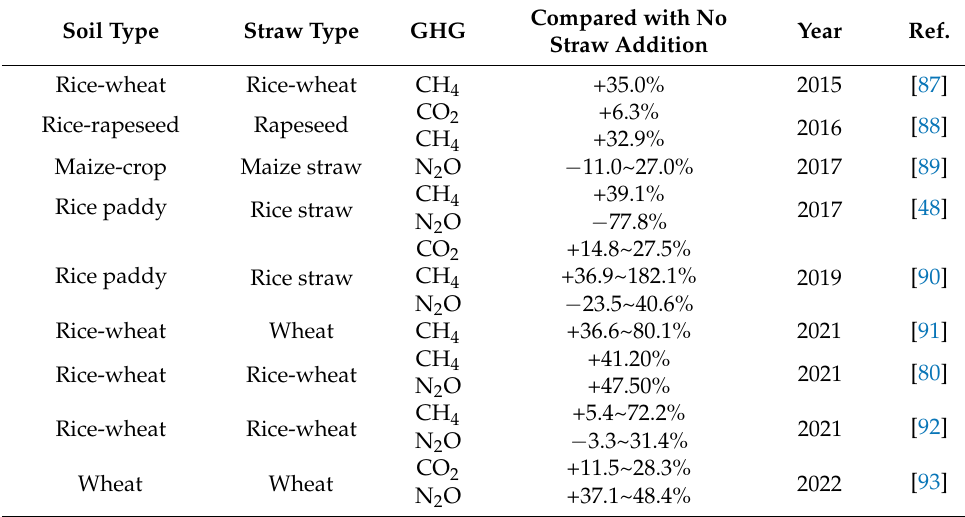
Table 1. The emission data of the GHGs from straw